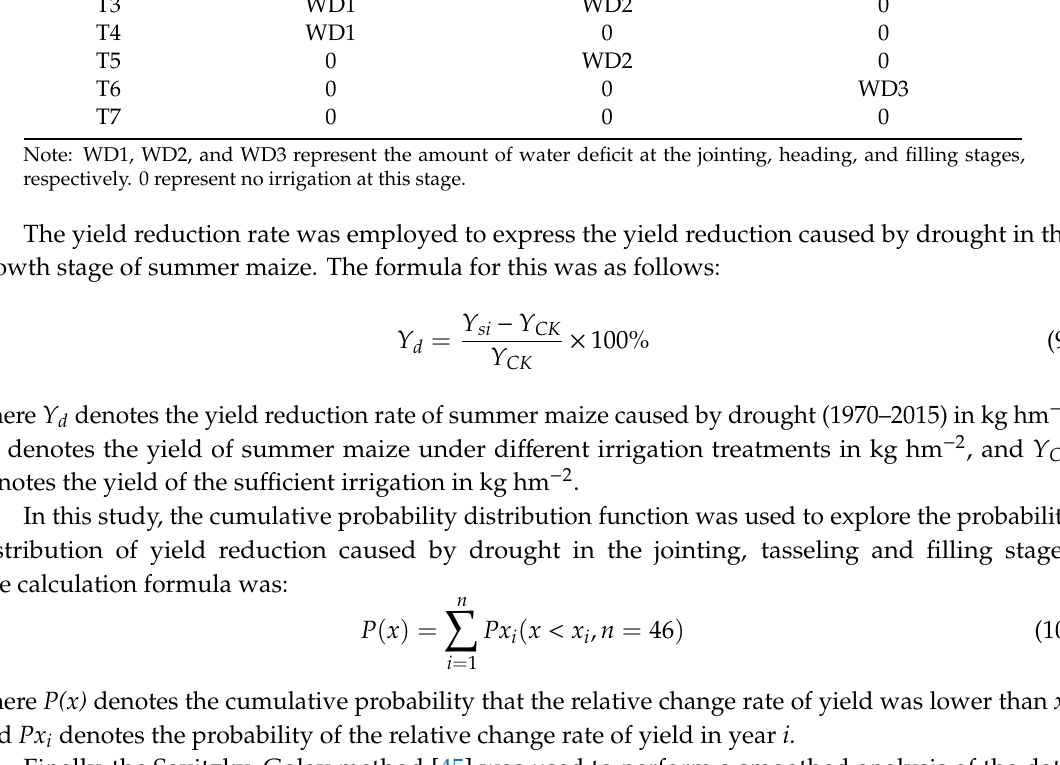
Irrigation Amount at Heading Stage / mm